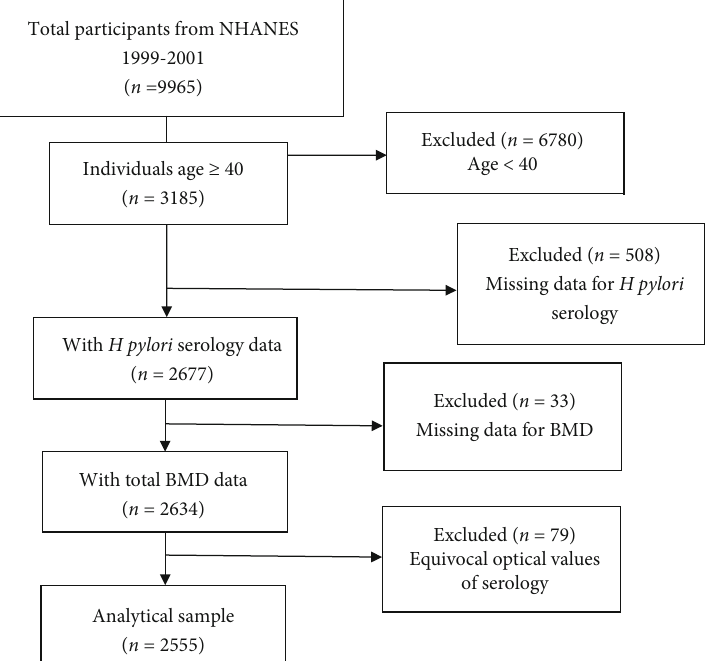
Figure 1: The sample selection fl ow